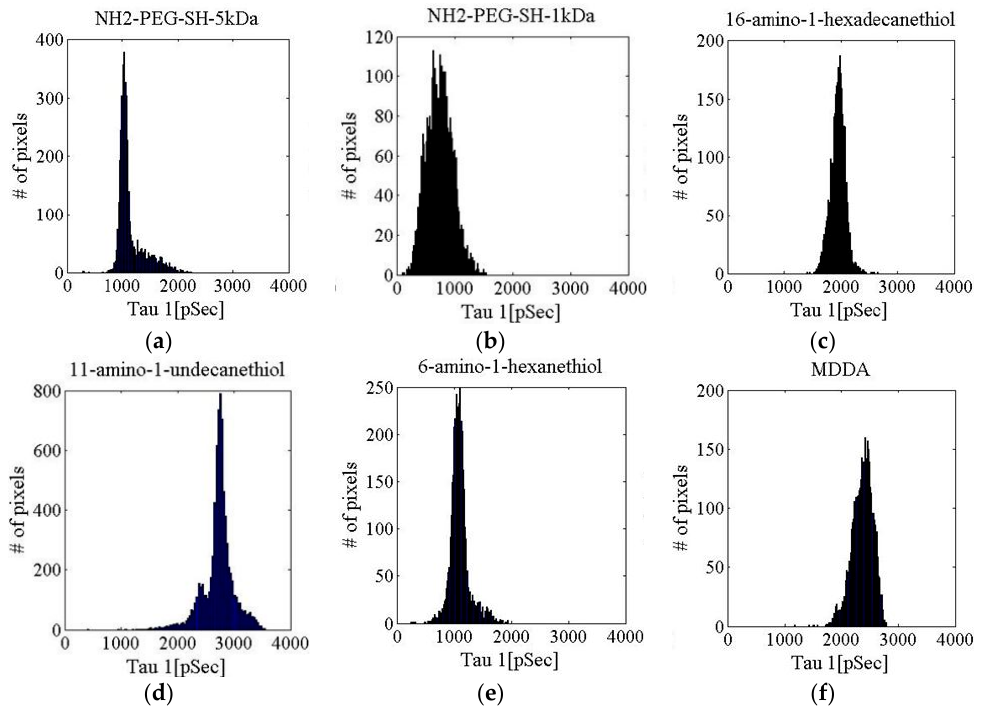
Figure 3. τ 1 histograms for fluorescein-conjugated GNR solutions with different linkers: ( a ) NH 2 -PEG- SH-5 kDa; ( b ) NH 2 -PEG-SH-1 kDa; ( c ) 16-amino-1-hexadecanethiol; ( d ) 11-amino-1-undecanethiol; ( e ) 6-amino-1-hexanethiol; ( f ) MDDA (Au concentration 1 mg/mL, fluorescein concentration 6.6 µM).